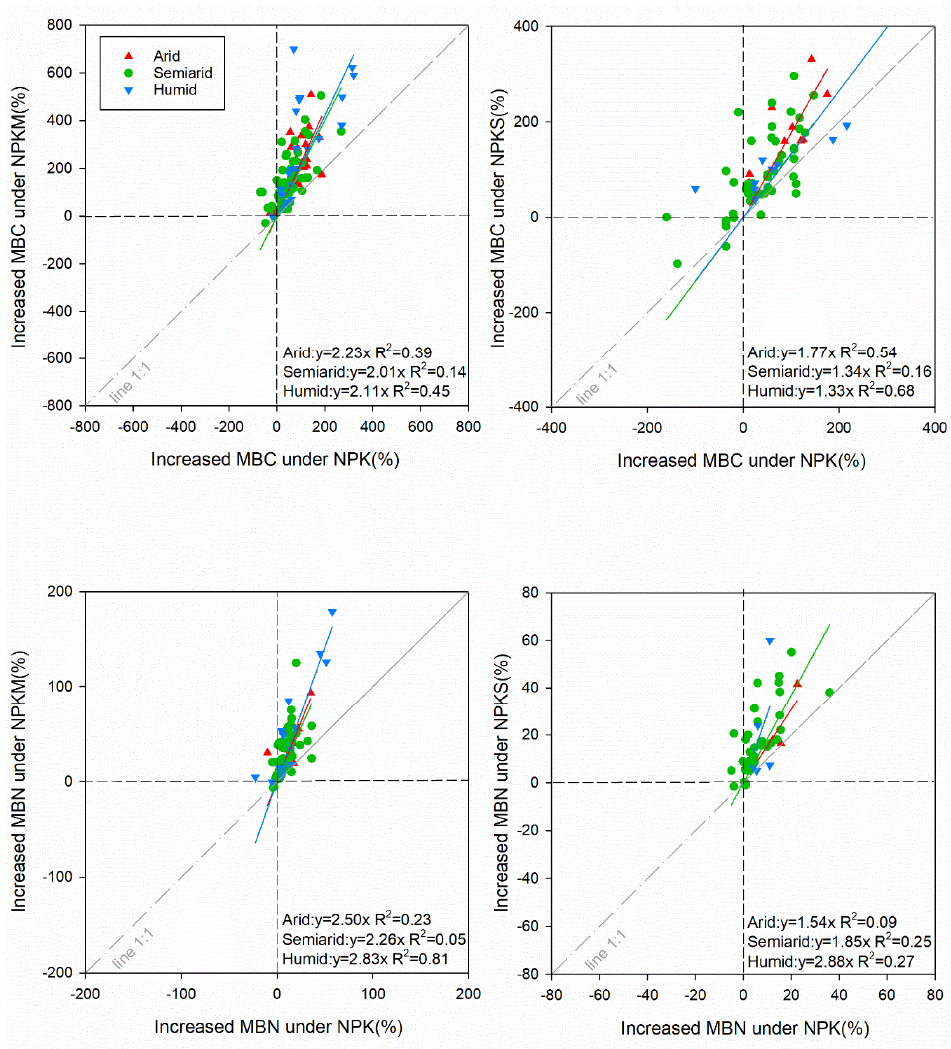
Figure 7. The linear relationships (y = ax) between the percentage changes of increased MBC and MBN under NPK and NPKM treatments depending on the HI (humidity index). The dashed lines show 1:1 ratios and colored lines reflect the linear regressions. All regression lines are significant at p < 0.05.